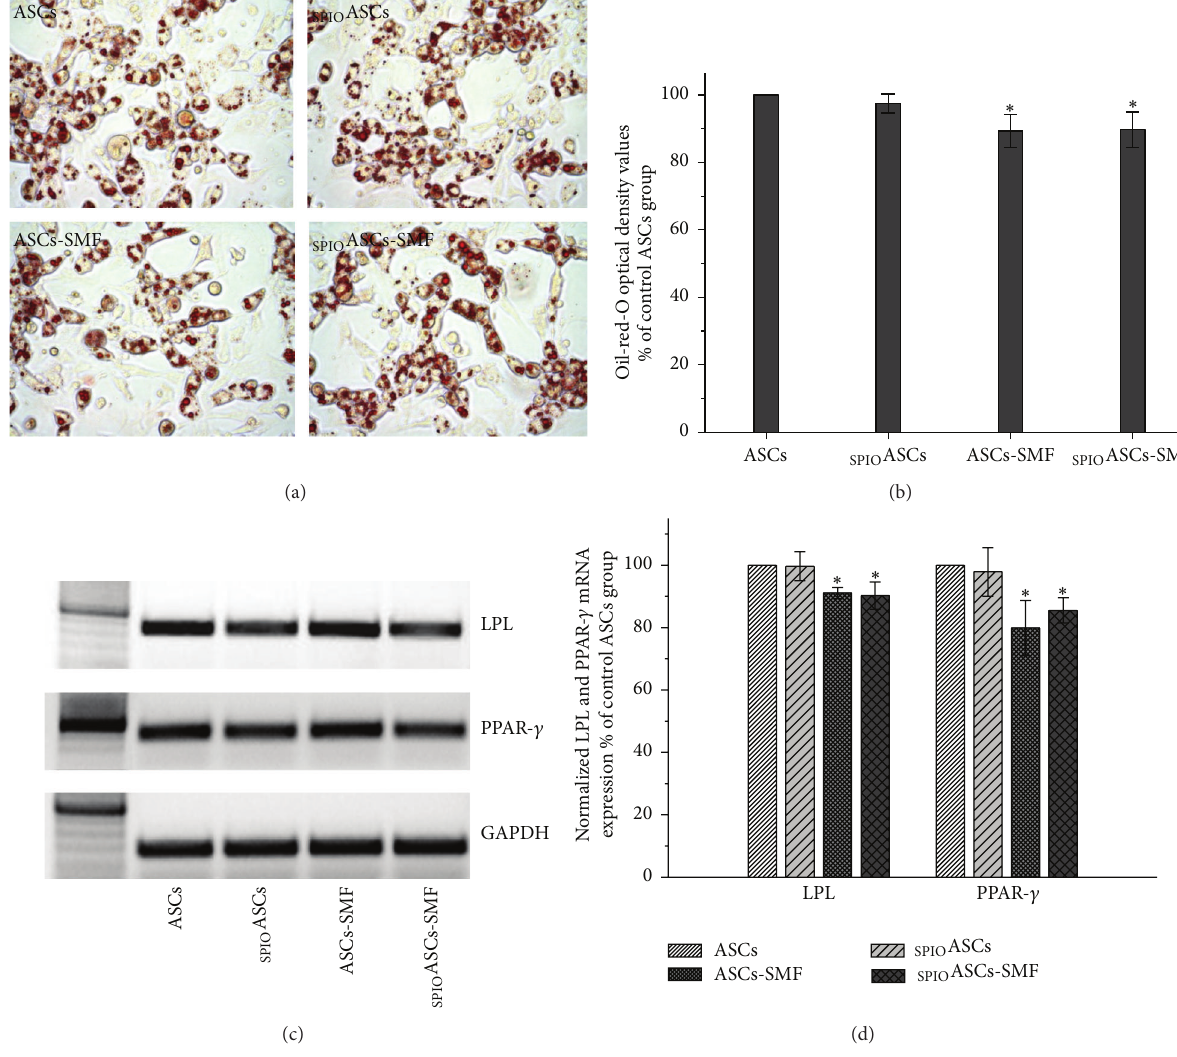
Figure 6: Effect of seven-day exposure to 0.5 T SMF on adipogenic differentiation in ASCs and SPIO ASCs. (a) Representative results of histochemical staining for Oil-o-red. (b) Quantification after normalization to levels from control ASCs. The Oil-o-red optical density value was significantly lower in the ASCs-SMF and SPIO ASCs-SMF than in ASCs and SPIO ASCs. (c) Representative results of RT-PCR for LPL and PPAR- 𝛾 . (d) Quantification after normalization to levels from control ASCs. The expression of mRNA for LPL and PPAR- 𝛾 was significantly lower in the ASCs-SMF and SPIO ASCs-SMF than in ASCs and SPIO ASCs. Scale bar represents 100 𝜇 m. ∗ 𝑃 < 0.05 versus ASCs or SPIO ASCs.